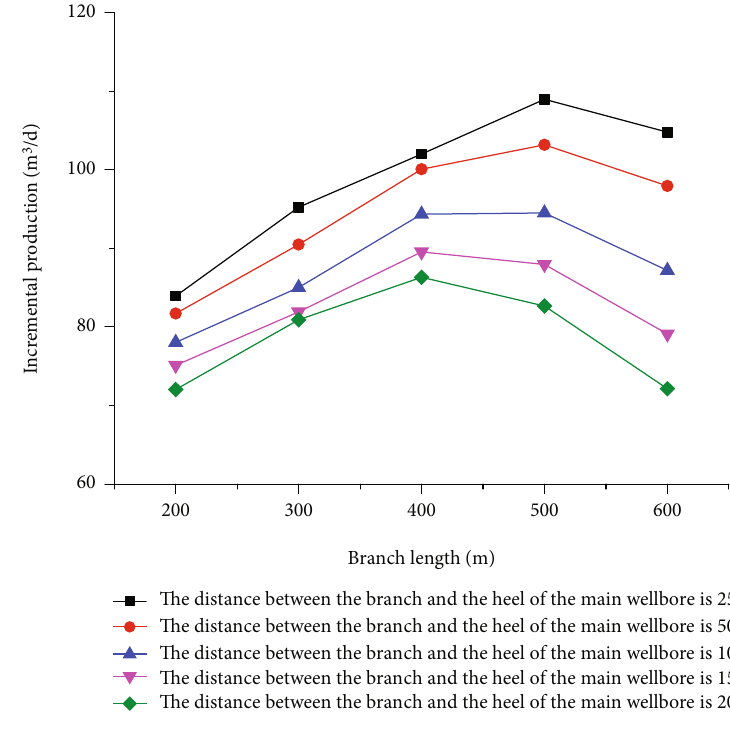
Figure 9: Incremental production with di ff erent branch lengths.